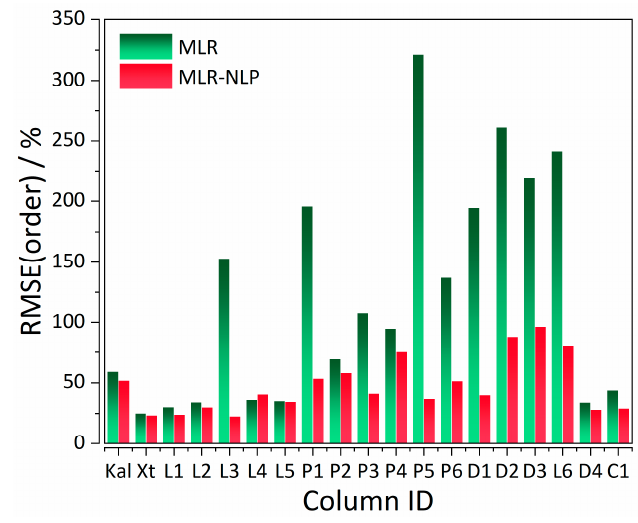
Figure 3. Distribution of %RMSE (order) values of MLR (control) and MLR-NLP models. The legend for the X-axis is analogous to the one in Figure 2.